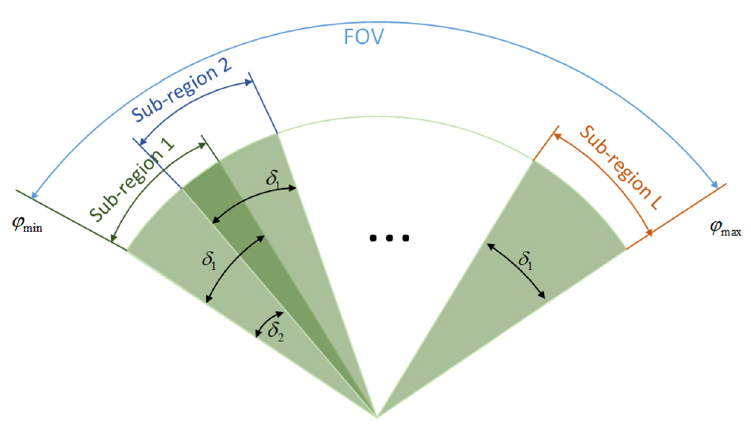
Figure 3. The subregions division method.